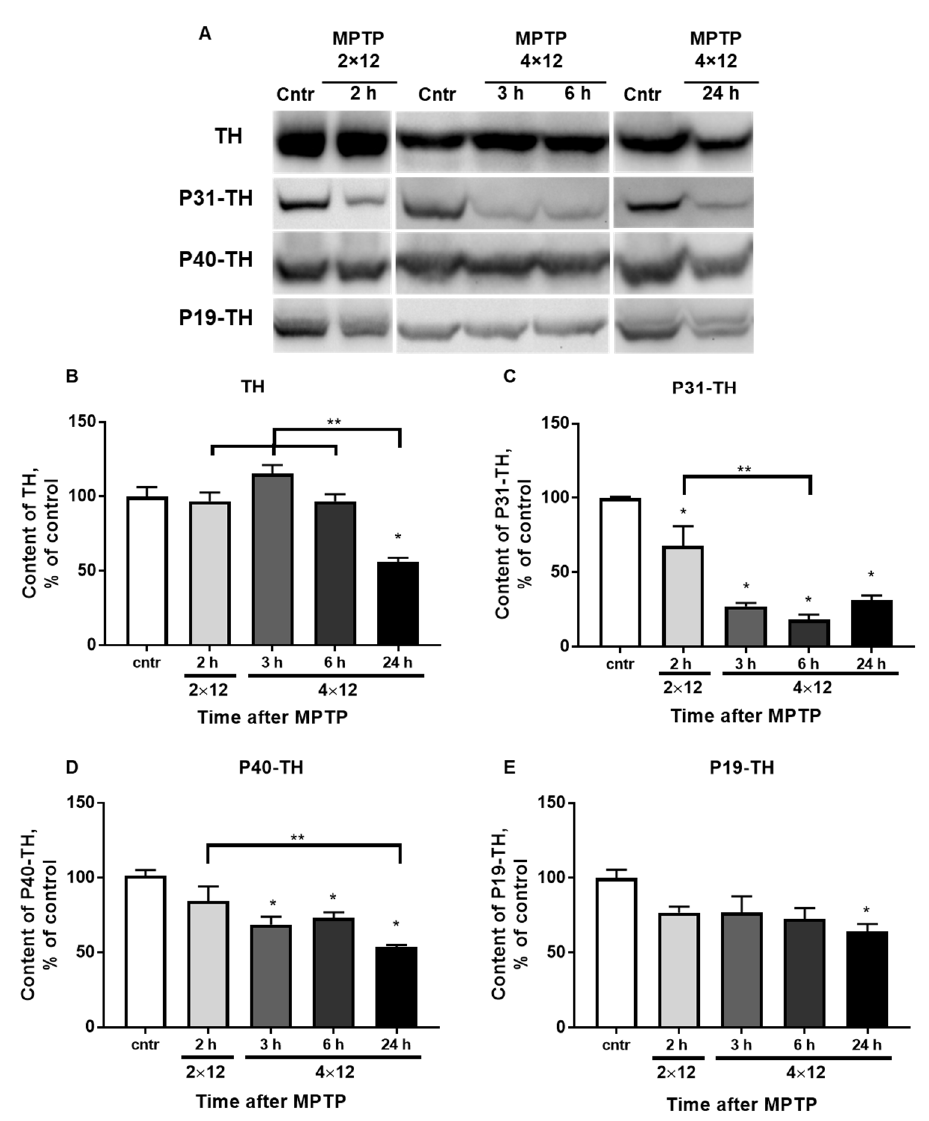
Figure 5. ( A ) Western blot representation of TH, P31-TH, P40-TH, and P19-TH immunoreactivity in the striatum of the control and 2 h after 2 × 12 mg/kg of MPTP and 3, 6, and 24 h after 4 × 12